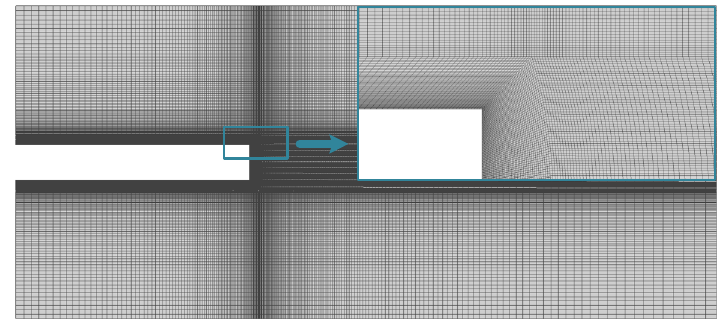
Figure 2. Schematic of grid elements.